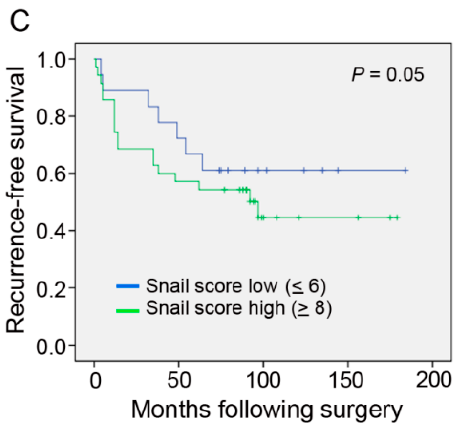
Figure 4. Kaplan-Meier survival curves showing relationships of the phosphorylated (p)-Akt image score ( A ), Gleason score sum ( B ), and Snail image score ( C ) in primary tumors with recurrence-free survival in 53 patients with clinically-localized prostate cancer. The recurrence-free survival of patients with a higher p-Akt, Snail image score ( ≥ 8) or Gleason score sum ( ≥ 7) was significantly lower than that of patients with a lower p-Akt, Snail image score ( ≤ 6) or Gleason score sum ( ≤ 6) ( p ≤ 0.05, log-rank test).